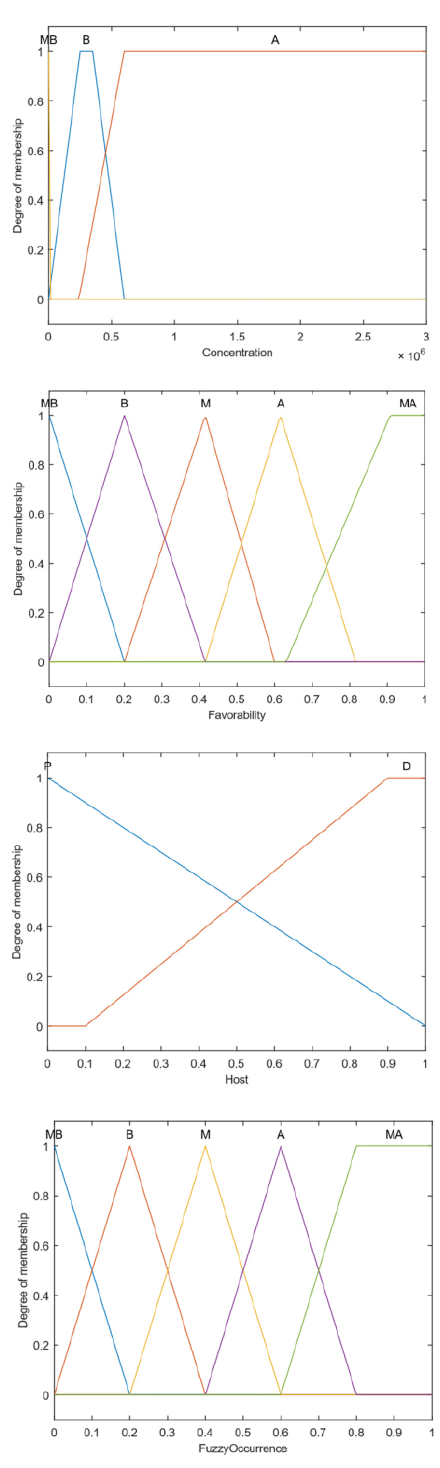
Figure 2. Fuzzy Sets representing the variables of Fuzzy Rust